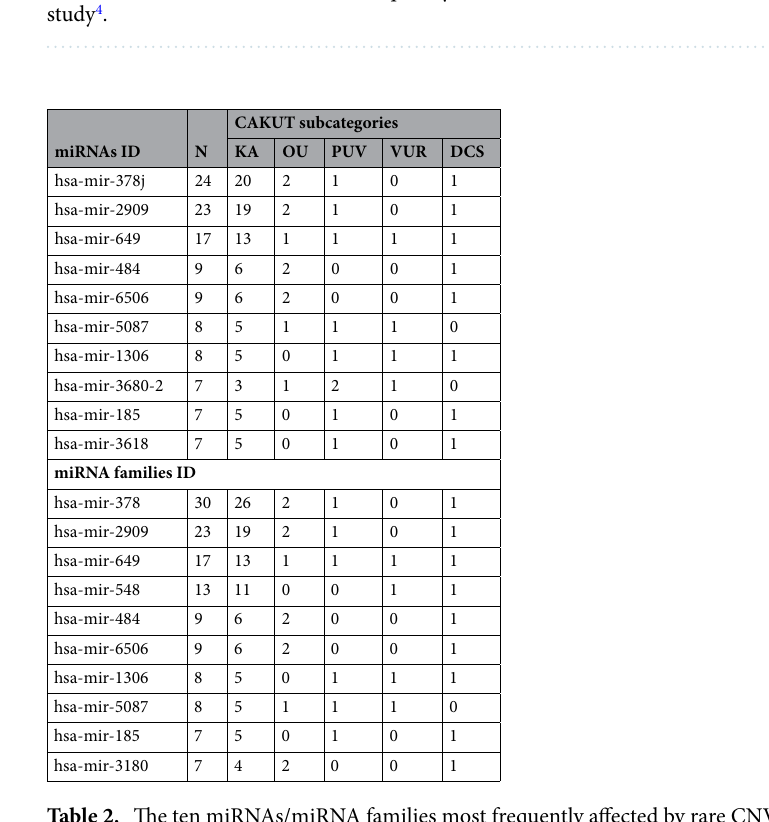
Table 2. The ten miRNAs/miRNA families most frequently affected by rare CNVs in CAKUT patients. N – number of patients harboring rare CNV which contains specific miRNA/miRNA family. CAKUT subcategories: KA – kidney anomalies, OU – obstructive uropathy, PUV – posterior urethral valves, VUR – vesicoureteral reflux, DCS – duplicated collecting